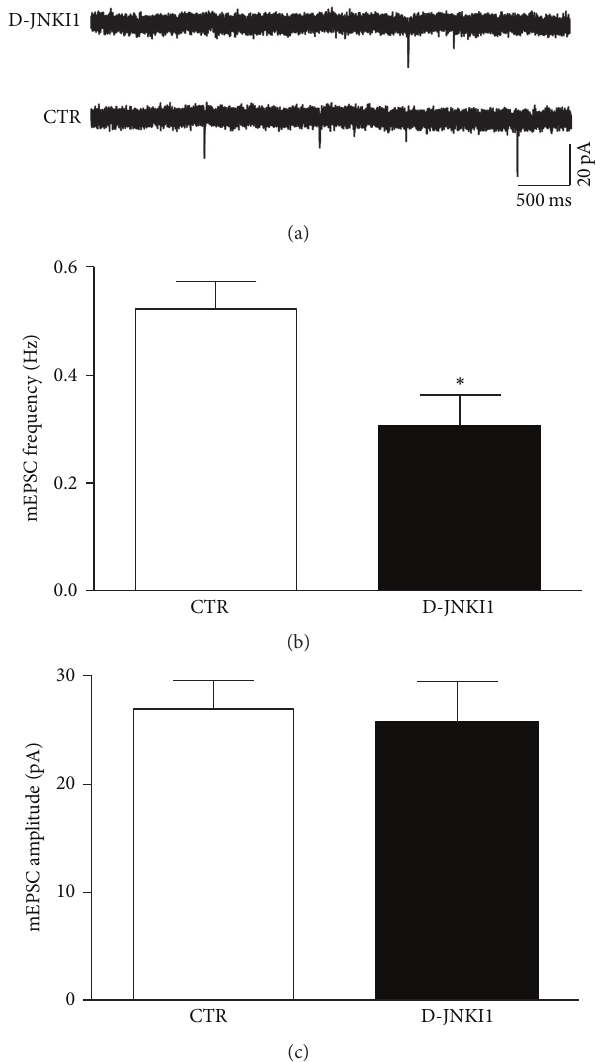
Figure 6: D-JNKI1 treatment reduced the frequency of mEPSCs in mice cortical slices. (a) Representative traces of mEPSCs recorded from cortical slices under control condition or after incubation with D-JNKI1n for 1hr. (b-c) Bar graph (mean ± SEM) showing the mEPSC frequency (b) and amplitude (c) obtained in the first 5 min of recordings from control ( 𝑁 = 8 ) and D-JNKI1-treated ( 𝑁 = 8 ) cortical neurons. CTR versus D-JNKI1 treatment: ∗ 𝑝 < 0.05 Student’s t-test, n =8. Data are shown as mean +/ −